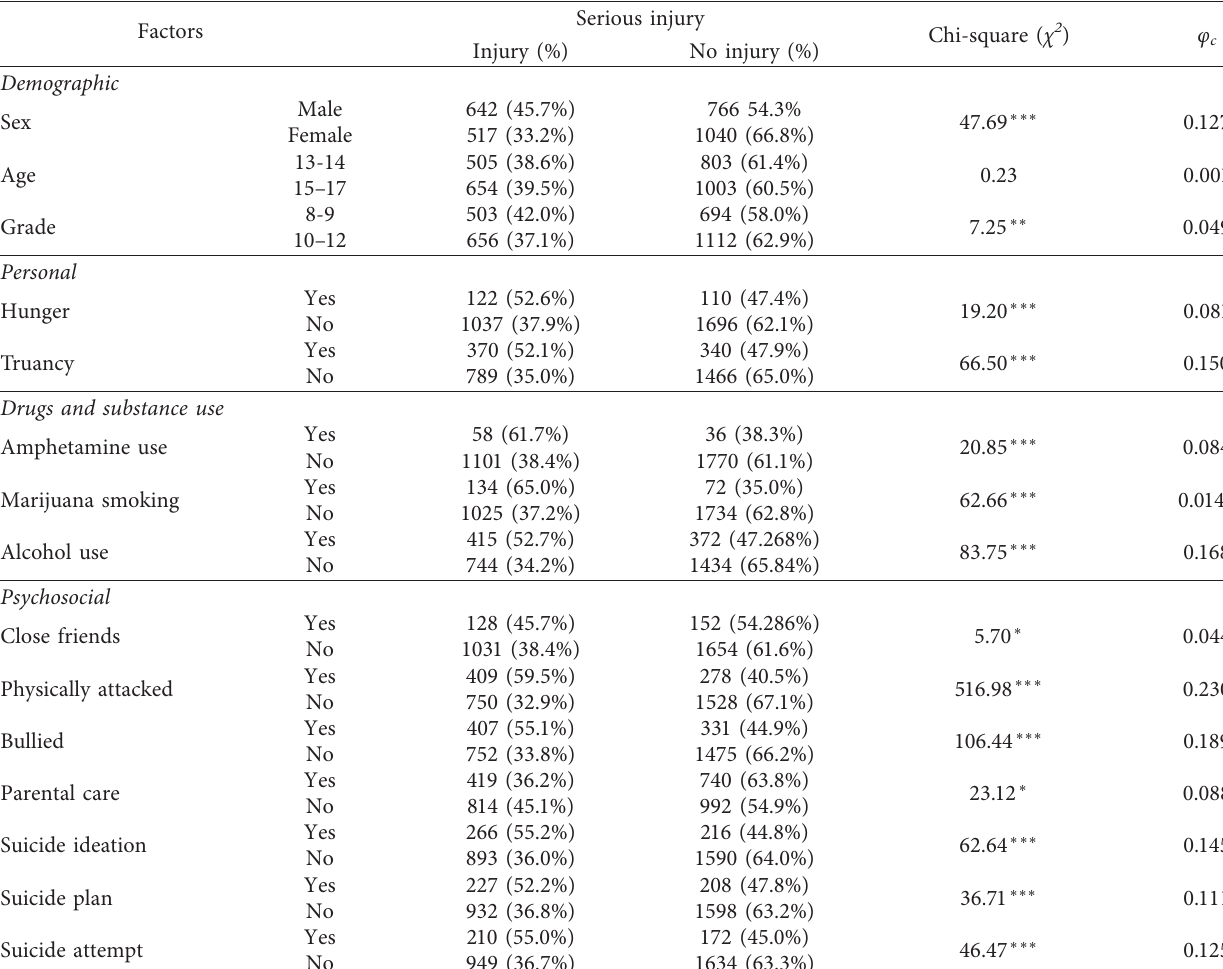
Table 2: Bivariate analysis of injuries among adolescents of school-going age in grades eight and twelve in Mauritania ( n � 2965).